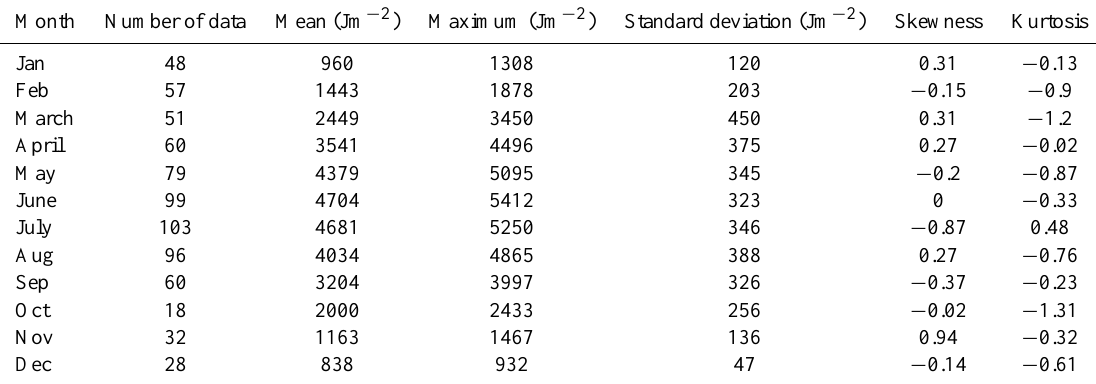
Table 2. Statistical parameters of daily ultraviolet erythemal irradiation for each calendar month for cloud-free